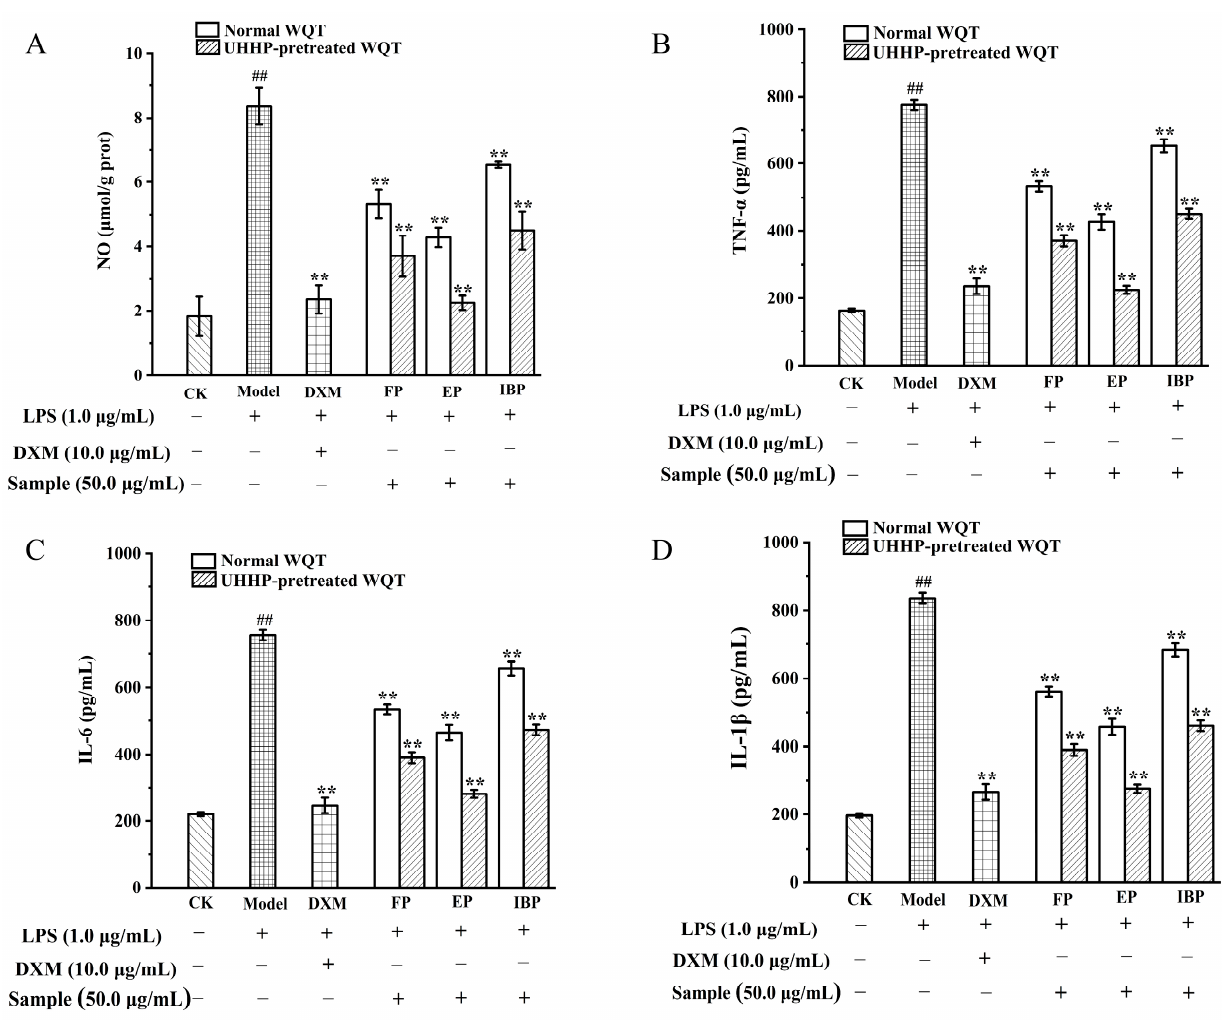
Figure 5. The inhibiting effects of NO and pro-inflammatory factors (TNF- α , IL -6, and IL-1 β ) produced by LPS-induced RAW264.7 cells from the normal and UHHP-pretreated White Que Zui tea (WQT). ( A ): NO content; ( B ): TNF- α ; ( C ): IL -6; ( D ): IL-1 β . ** p < 0.01 compared to the model group; ## p < 0.01 compared to the control group. All the values are expressed as mean ± SD (n = 3). FP and UFP: free phenolic fraction from normal and UHHP-pretreated WQT; EP and UEP: esterified phenolic fraction from normal and UHHP-pretreated WQT; IBP and UIBP: insoluble-bound phenolic fraction from normal and UHHP-pretreated WQT.